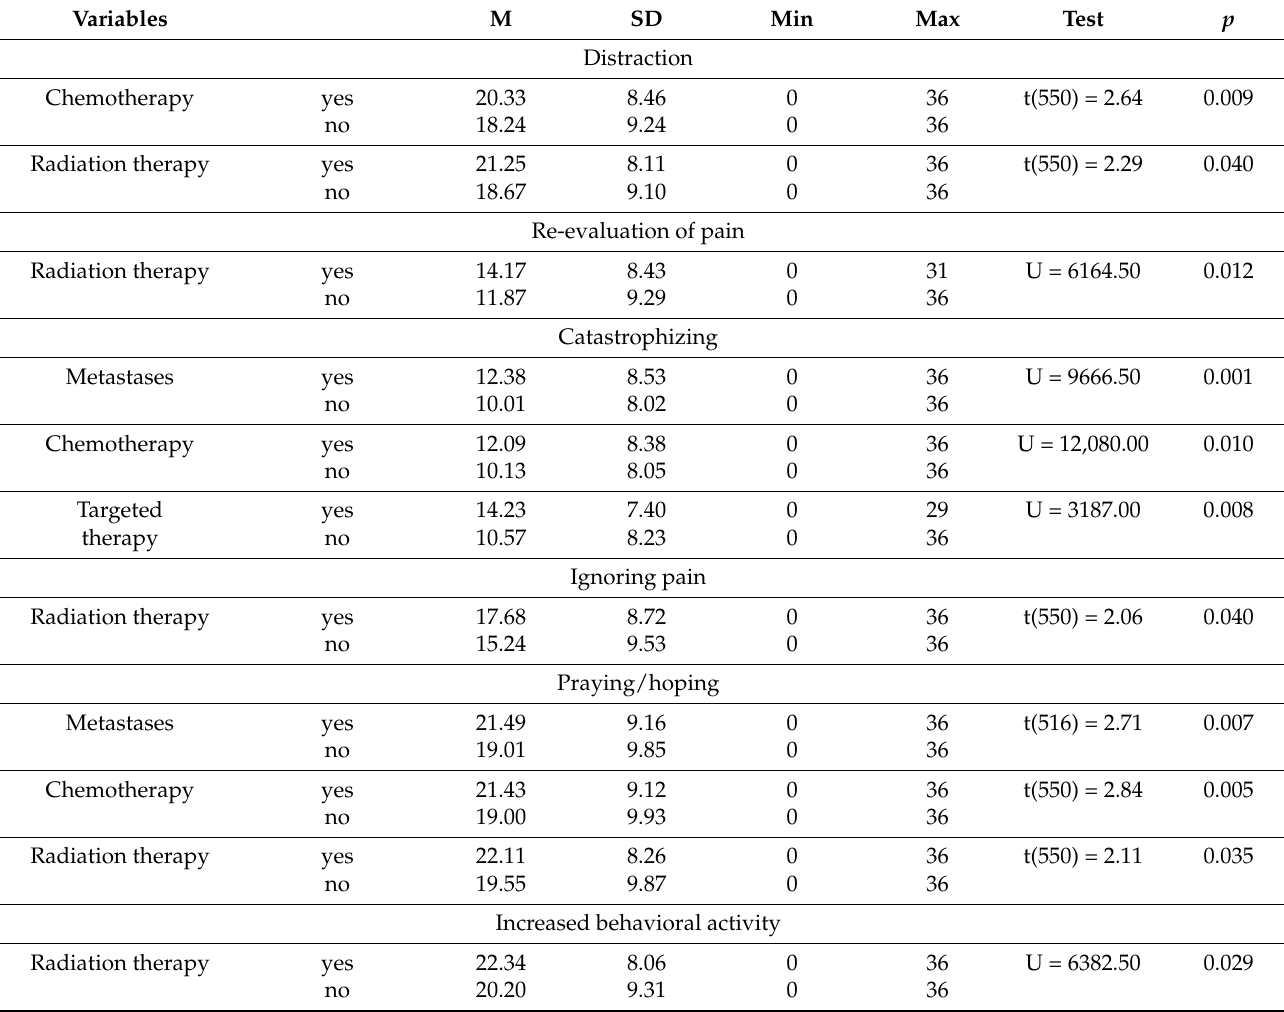
Table 3. Disease indicators differentiating CSQ test